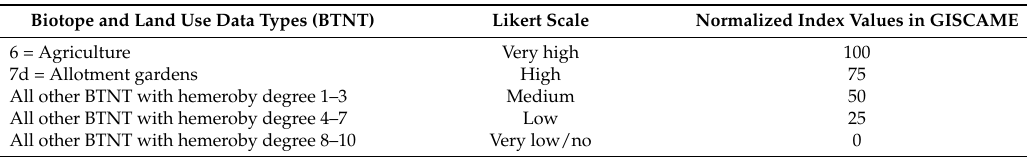
Table 9. Five-point Likert scale for the ecosystem service “food supply”. Value 100 = highest ecosystem service capacity; 0 = lowest/no ecosystem service